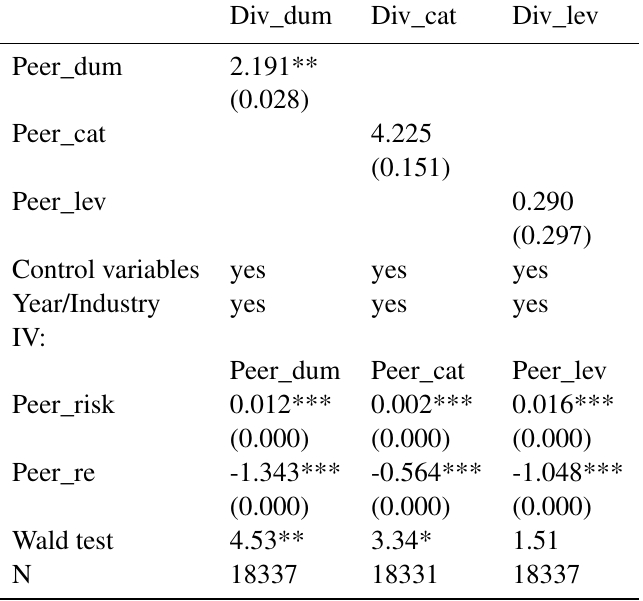
Table 4 Peer influence on dividend